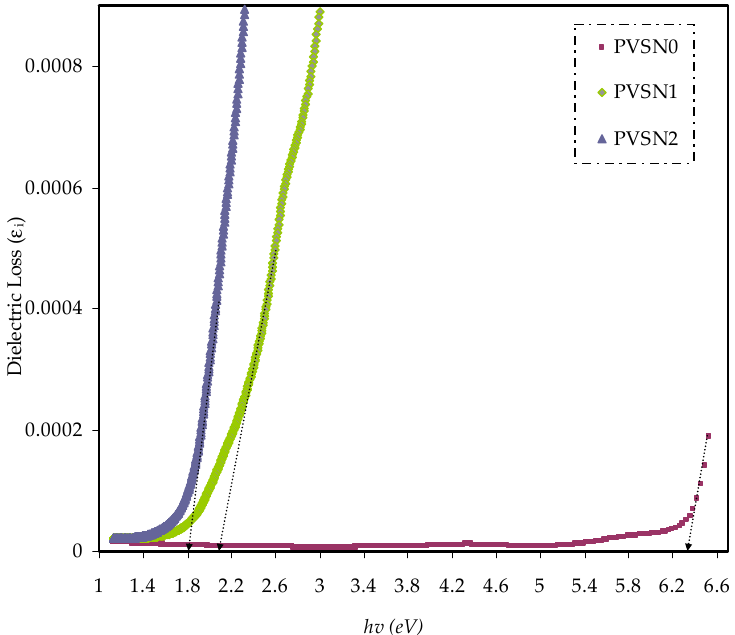
Figure 16. Plot of ε i vs. h υ for PVA and PC Figure 16. Plot of ԑ i vs. h υ for PVA and PC films.